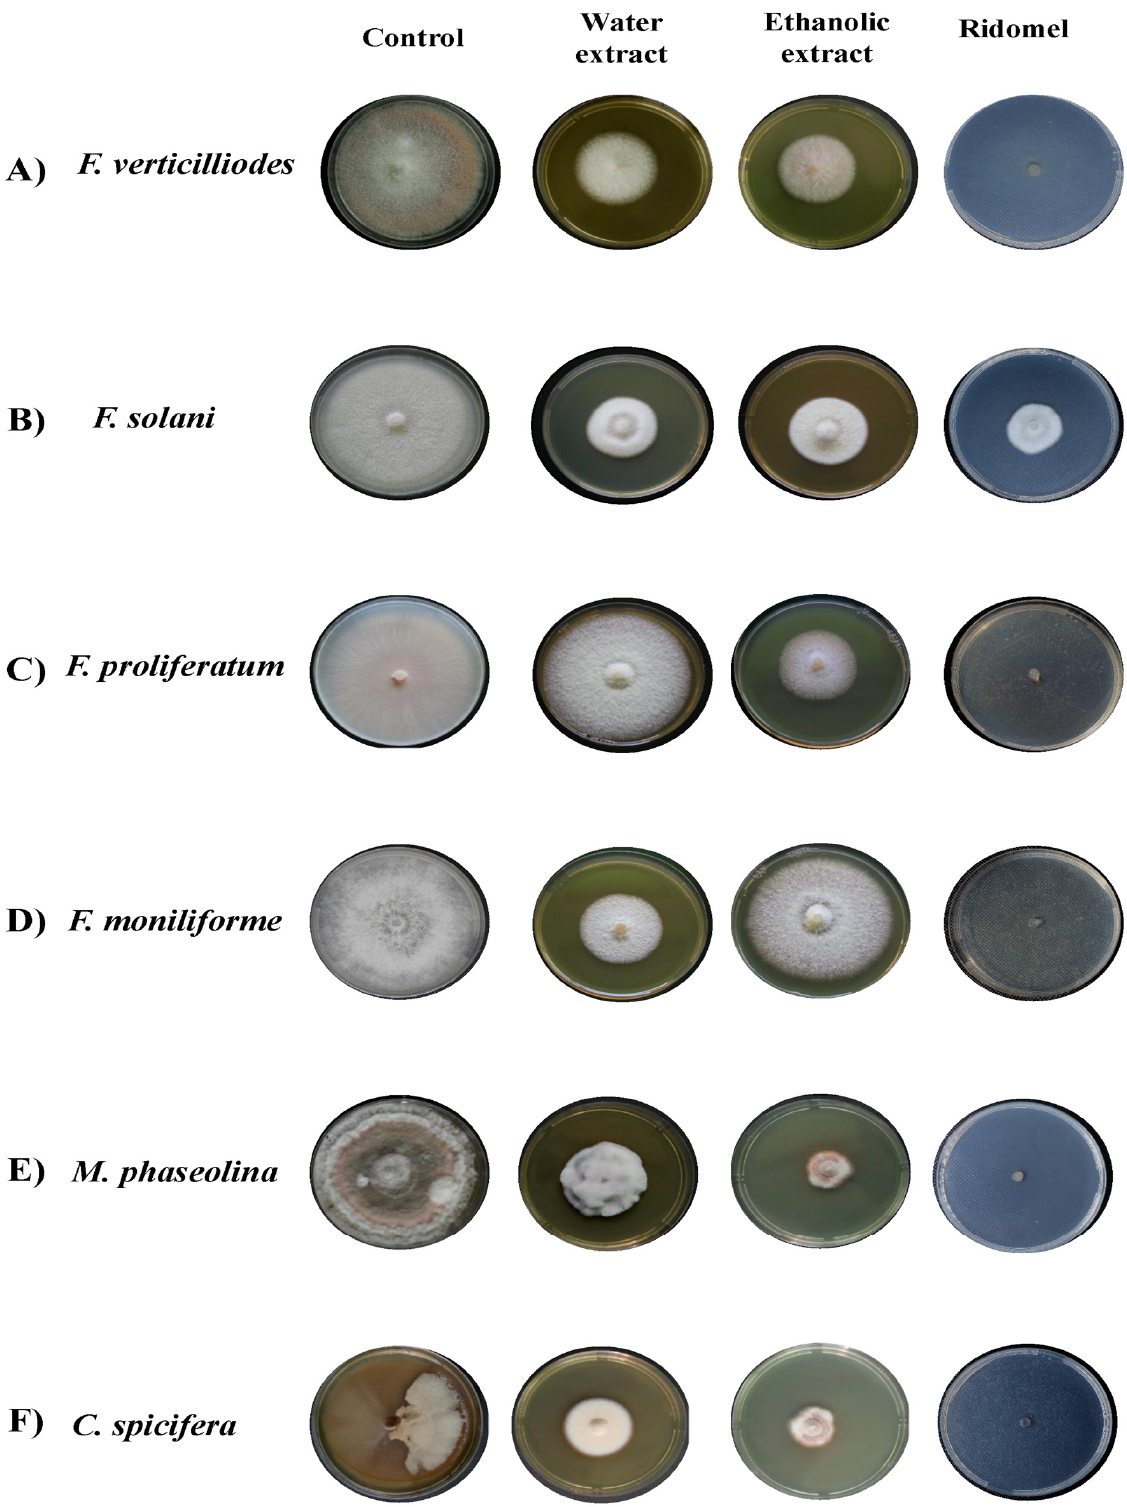
Figure 1. Antifungal effects of T. aphylla leaf extracts against different phytopathogenic fungi. The species were growing on PDA Petri dishes and treated with either ethanolic or water extracts of T. aphylla (30%). The mycelial growth was compared to the untreated control and the positive fungicide (Ridomil, 0.5 mg/mL). ( A ) F. verticilliodes , ( B ) F. solani , ( C ) F. proliferatum , ( D ) F. moniliforme , ( E ) M. phaseolina , and ( F ) C. spicifera.